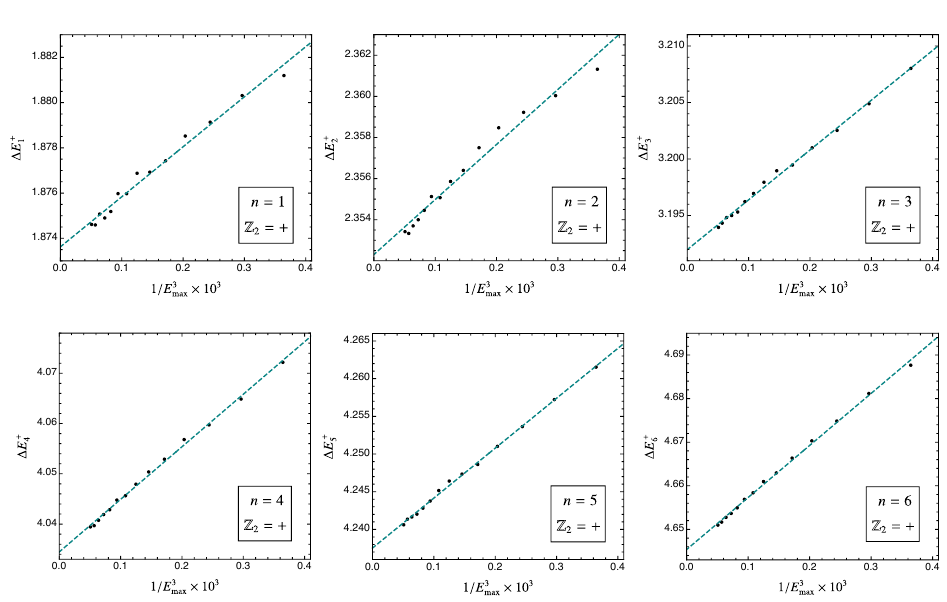
Fig. 4. The excitation energy ∆ E proved theory as a function of 1 / E 3 λ/ 4 π = 1, m = 1, 2 π R = 10. NO